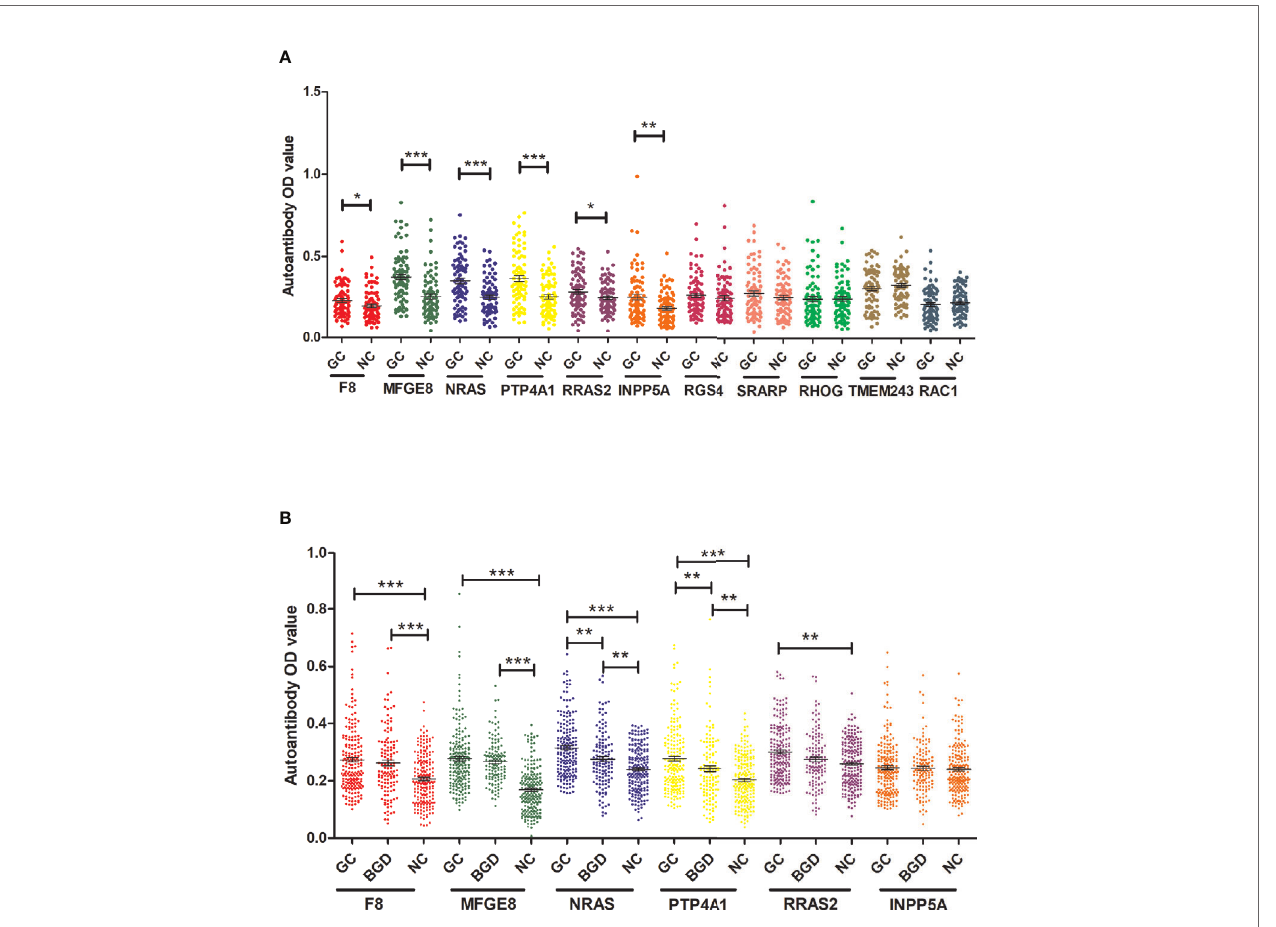
FIGURE 2 | The titer of 11 anti-TAAs autoantibodies in GC cases and HCs. (A) Scatter plots of the titer of autoantibodies in the veri fi cation cohort, (B) scatter plots of the titer of autoantibodies in the validation cohort. GC, gastric cancer; HC, healthy controls; BGD, benign gastric disease. (* P < 0.05, ** P < 0.01, *** P <